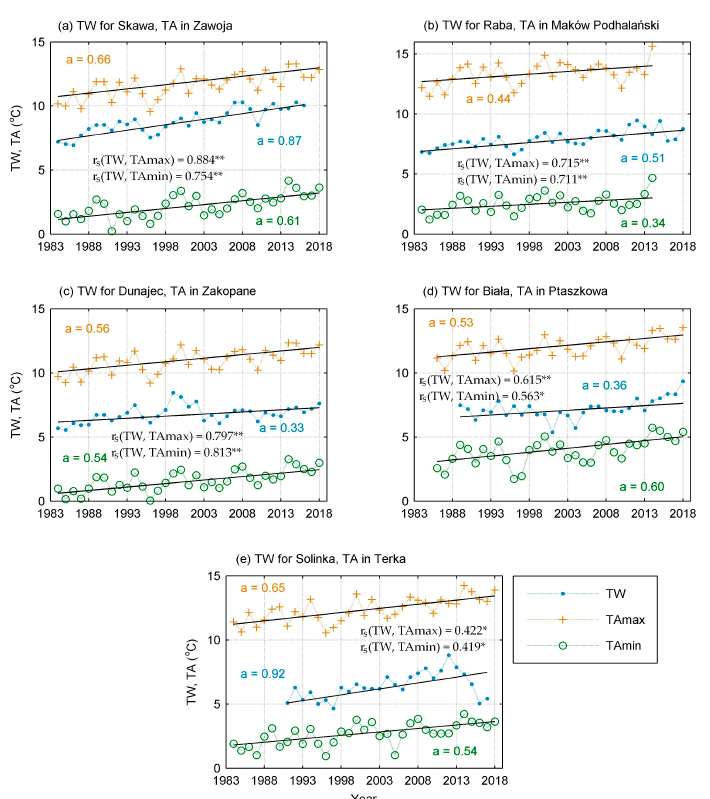
Figure 2. The course of annual water and air temperatures, and significant ( p < 0.05) trend intensity a ( ◦ C per decade) for the studied rivers in comparison to air temperatures (TAmin, TAmax) at neighboring stations. The comparisons were made for: ( a ) TW for the Skawa in Wadowice and TA in Zawoja; ( b ) TW for the Raba in Str ó ˙za and TA in Mak ó w Podhala´nski; ( c ) TW for the Dunajec in Nowy Targ-Kowaniec and TA in Zakopane; ( d ) TW for the Biała in Gryb ó w and TA in Ptaszkowa; ( e ) TW for the Solinka in Terka and TA in Terka. Spearman’s rank correlation coe ffi cient ( r s ) shows a significant correlation between the annual water temperature series and the annual air temperature series (TAmin, TAmax); r s significant at p < 0.001 and p < 0.05 was marked ** and *,